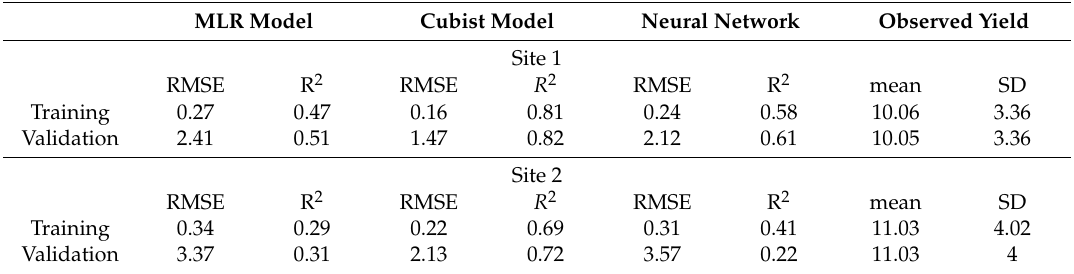
Table 6. Prediction errors (training and validation) provided by the MLR and Cubist model in the multiple year analysis.